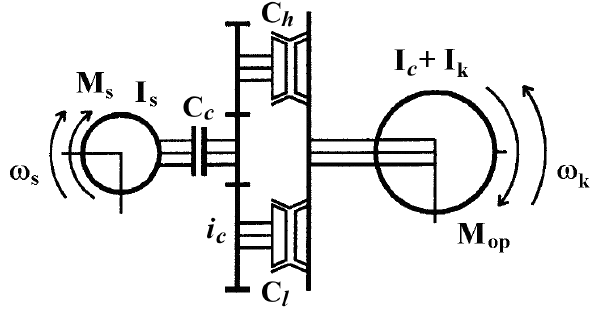
Figure 1: Dynamic scheme of the car system with mechanical trans- mission [own